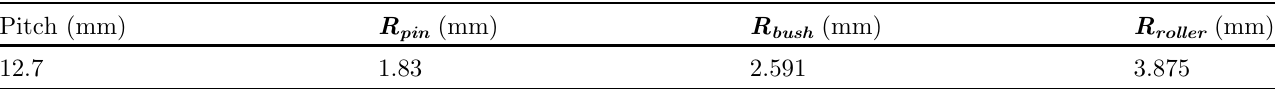
Table 3. Chain characteristics. Pitch